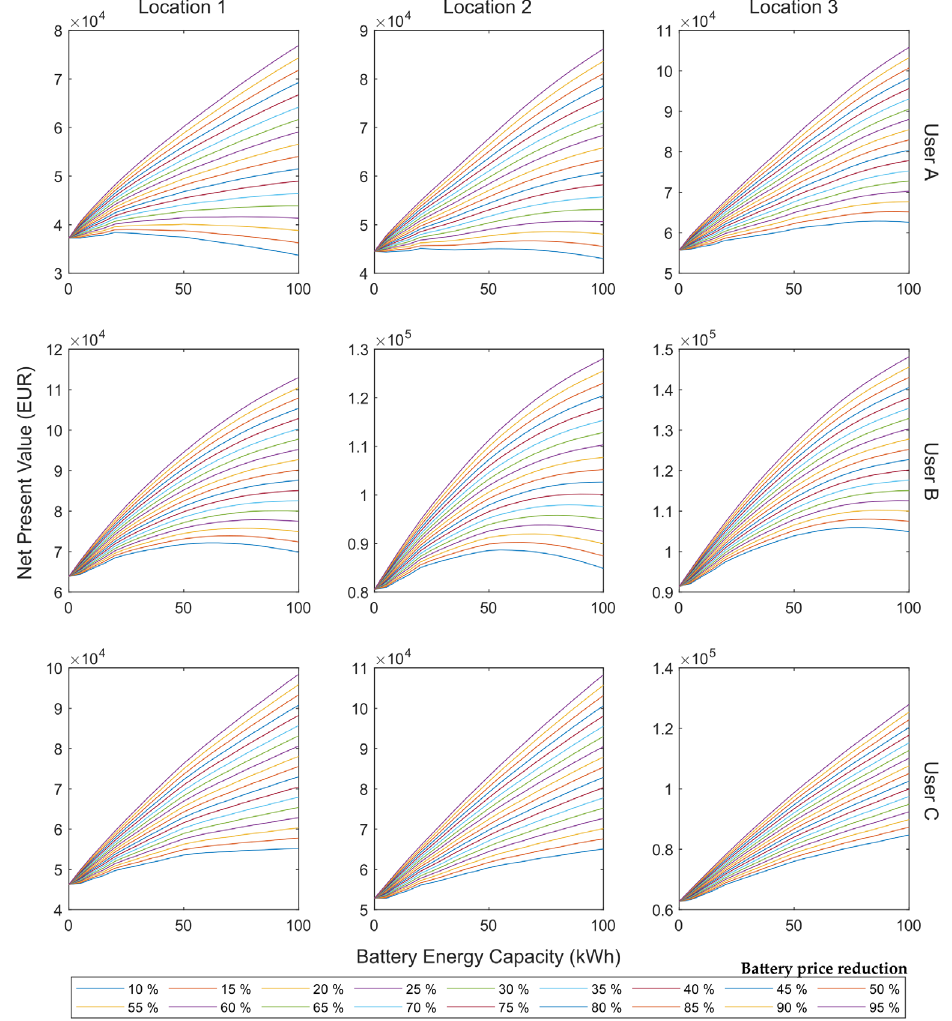
Figure 6. Optimal storage capacity according to battery prices for the users and locations analyzed using self-consumption model 1.